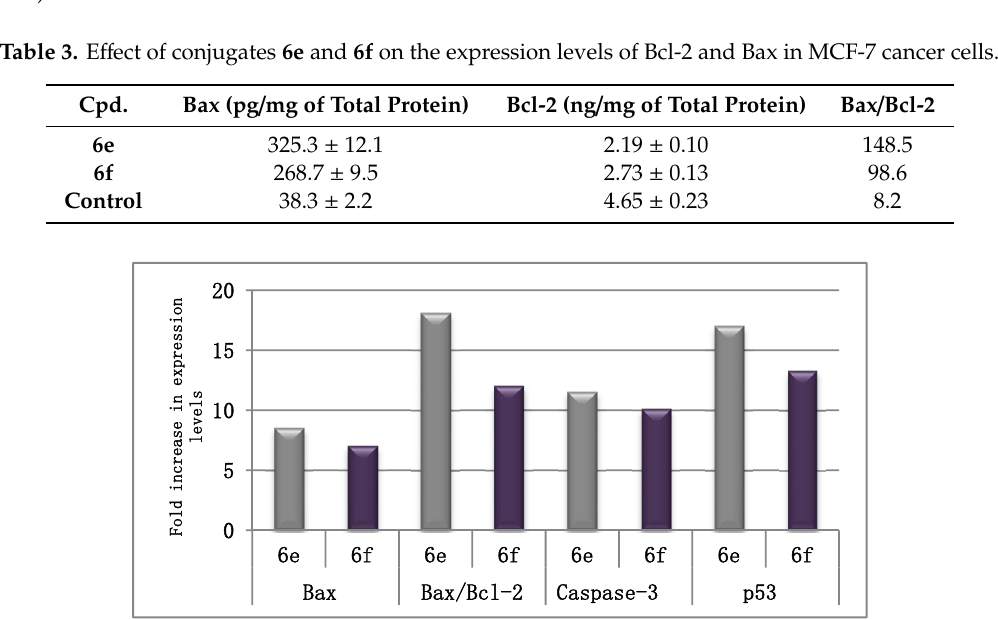
Figure 3. The extent of fold increase on the Bax / Bcl-2 ratio, in addition to expression levels of Bax, caspase-3, and p53 in MCF-7 cells after treatment with compounds 6e and 6f , as compared to the control (1% DMSO).